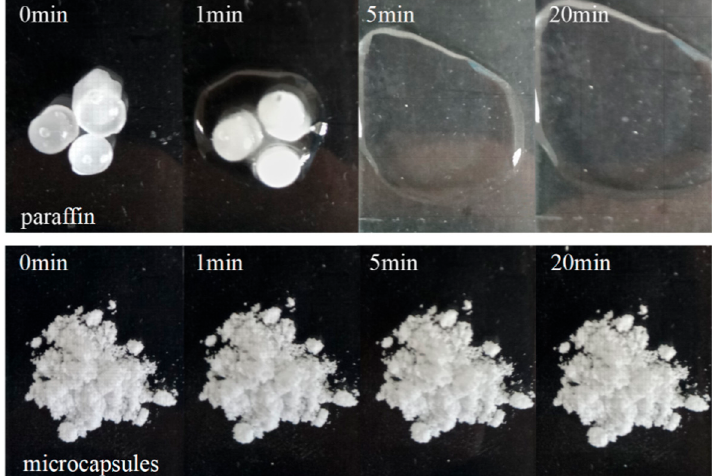
Figure 2. Photographs of the evolution of raw paraffin and paraffin/PUF microcapsules on hot-stage fixed at 70 °C.